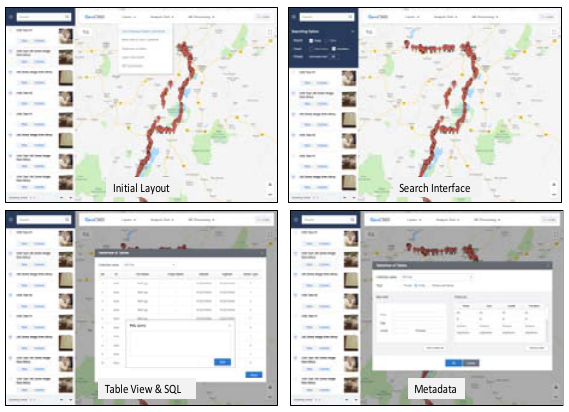
Figure 4. An example of a MovingVideo data